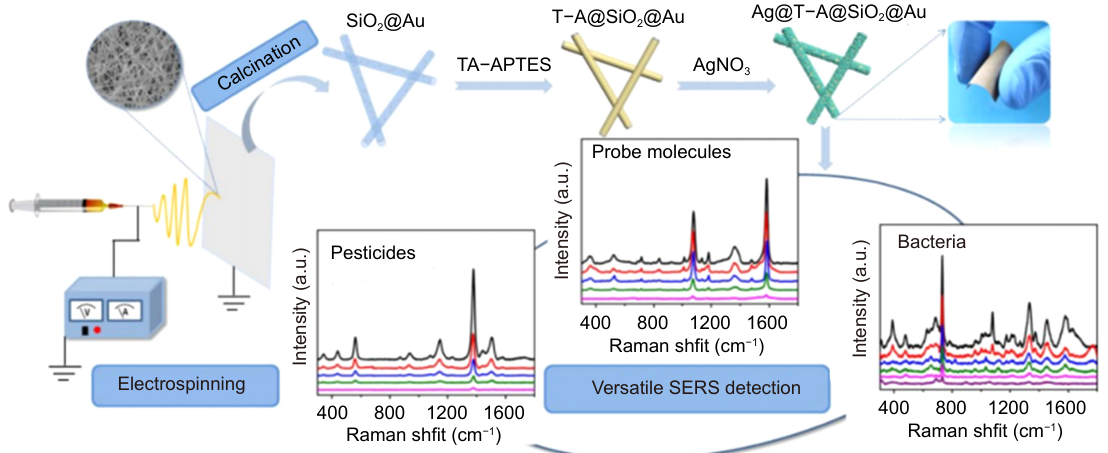
Fig. 8 | Fabrication of flexible SERS substrates for Ag@T-A@SiO 2 -Au nanofibrous substrates. Figure reproduced with permission